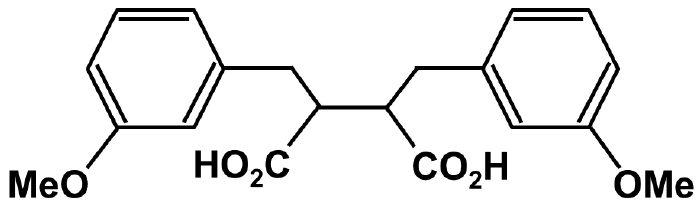
Figure 1. The structure of 1,2-bis[(3-methoxyphenyl)methyl] ethane-1,2-dicaroxylic acid (S4).